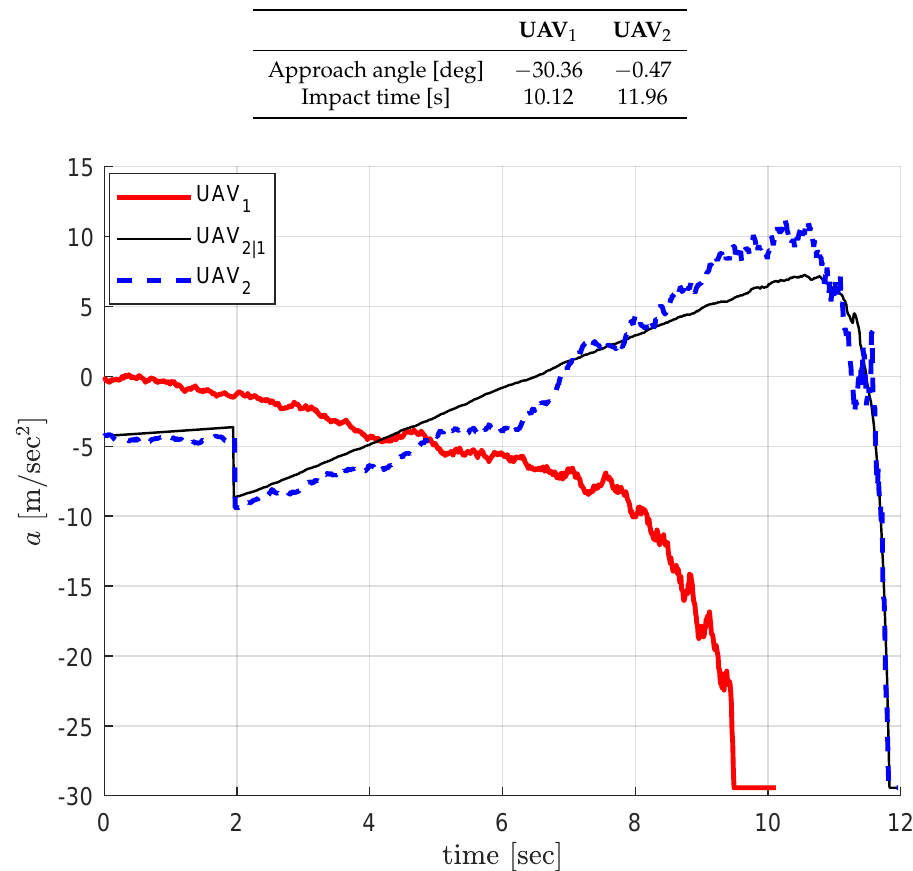
Figure 6. Decentralized cooperation: guidance commands. Thin black line (UAV 2 | 1) represents UAV 1 ’s best estimate on UAV 2 ’s guidance command, and the dotted blue line (UAV 2 ) represents the actual guidance command of UAV 2 as the sum a 2 = a 2 | 1 + ∆ a 2